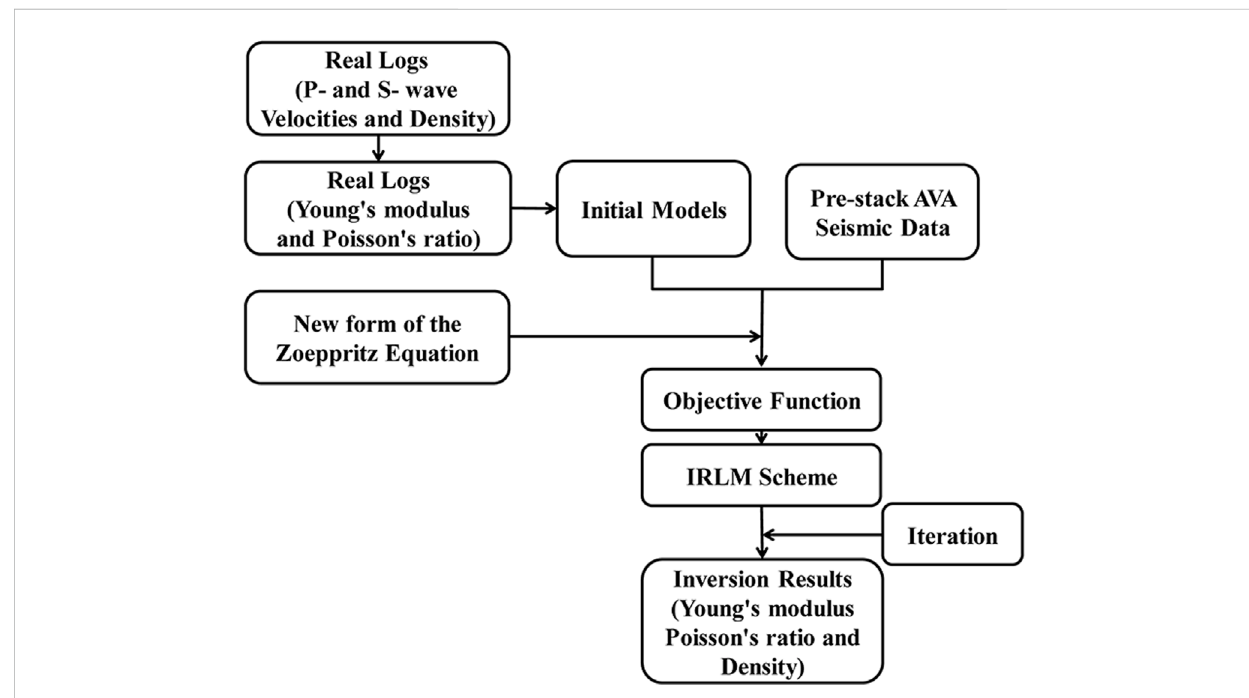
TABLE 2 Elastic parameters of a multilayer geologic test the precision of inversion results compared with the indirect calculated value. Figure 5A shows Young ’ s modulus, Poisson ’ s ratio, and density respectively. The synthetic P-to-P wave angle gathers (Figure 5B) are generated based on the convolution model with Eq. 8 and a 35 Hz zero-phase Ricker wavelet without noise. The incident angle is 0 ° – 50 ° to verify the robustness of the proposed inversion method in the synthetic examples at large incident angles. Reliable low-frequency information on model parameters is important for obtaining